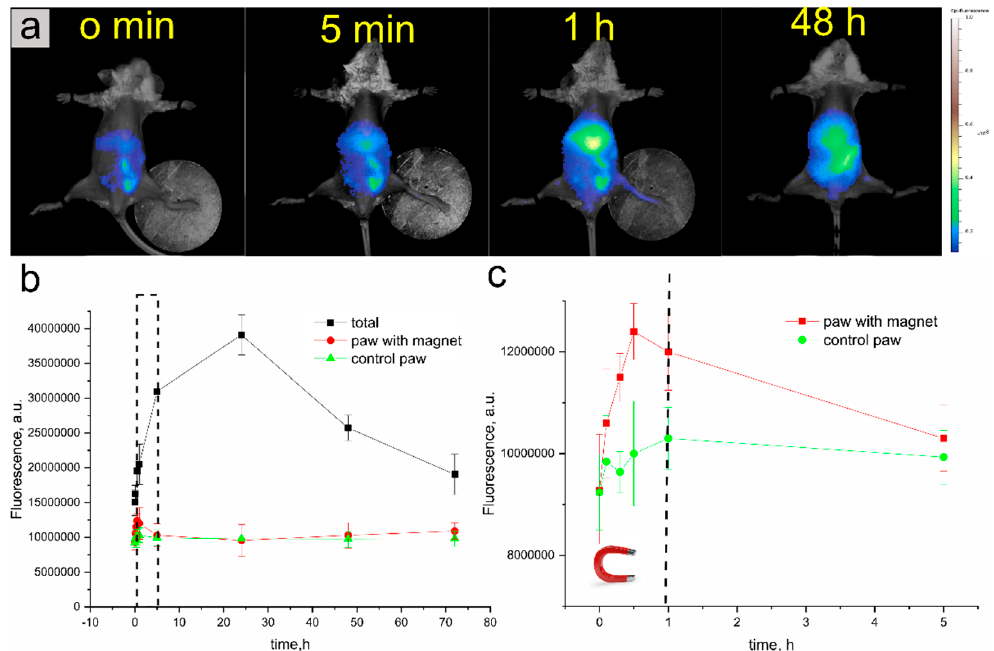
Figure 4. The organ distribution of carriers under the e ff ect of a magnetic field applied to a mouse paw (real-time visualization). ( a ), whole-body fluorescence imaging and distribution of carriers before and after injection into the mouse tail vein. ( b ), change in the total fluorescence signal of the mouse and signals received from both paws within 72 h. ( c ), change in the fluorescence signal from the moment of carrier administration to 5 h (area marked with a dotted red line in Figure 4b).